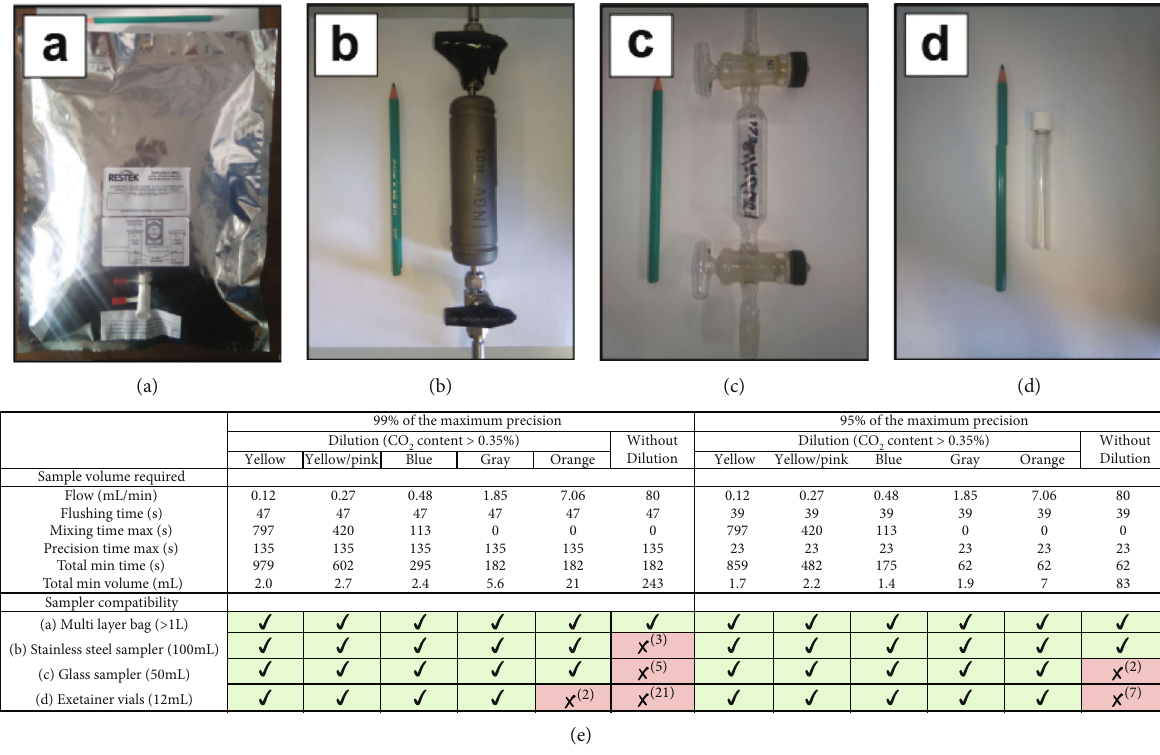
Figure 8: Assumption on the use of distinct gas samplers to perform analysis with the Delta Ray IRIS: (a) Multi-Layer bag ( > 1L), (b) stainless steel sampler ( ≈ 100 mL), (c) glass sampler ( ≈ 50mL), and (d) Exetainer vials (12 mL). (e) Estimation of the minimum volume of gas required to obtain precise (99% and 95% of the maximum precision) and accurate measurements in function of the dilution tube (or without) for the full range of CO contents from 200 ppm to 100%. Green- fi lled cells for accurate gas samplers. Red- fi lled cells for inaccurate gas samplers. In 2 the last case, the reported exposant highlights either the number of similar gas samplers required to perform the analysis (see text for